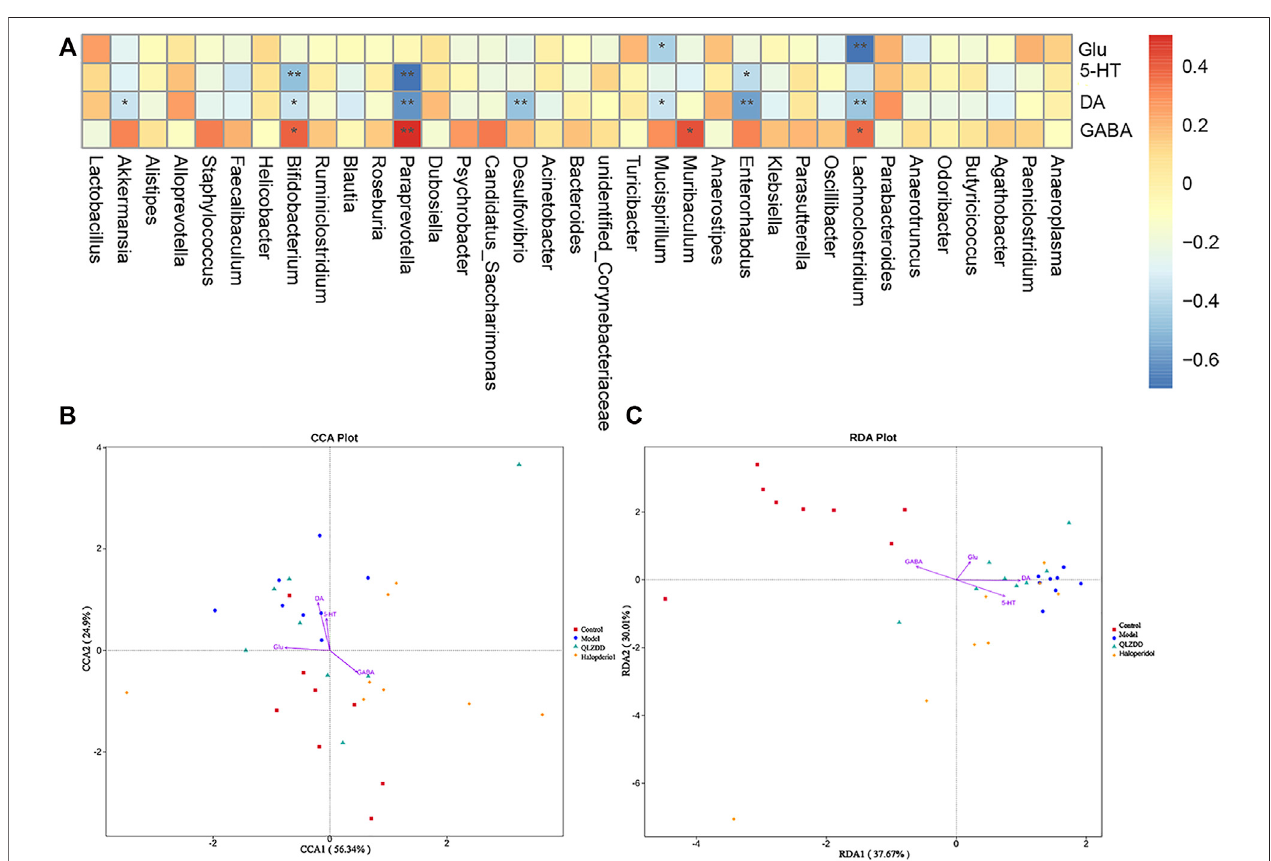
FIGURE 9 | Correlation analysis between gut microbiota and environmental factors (DA, Glu, GABA). (A) The correlation analysis map of the striatum biochemical index and the intestinal fl ora level of the mice. Each row of the correlation analysis map represents a neurotransmitter factor. The color-coded temperature is the Spearman ’ s correlation coef fi cient of n = 8 mice. * p < 0.05, ** p < 0.01, and *** p < 0.001. (B, C) The RDA) and the CCA of intracellular bacterial